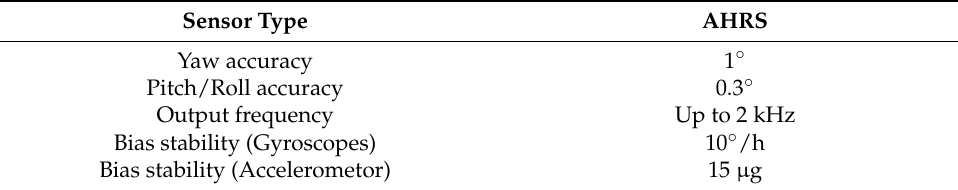
Table 3. Specification of AHRS used on the AUV platform.